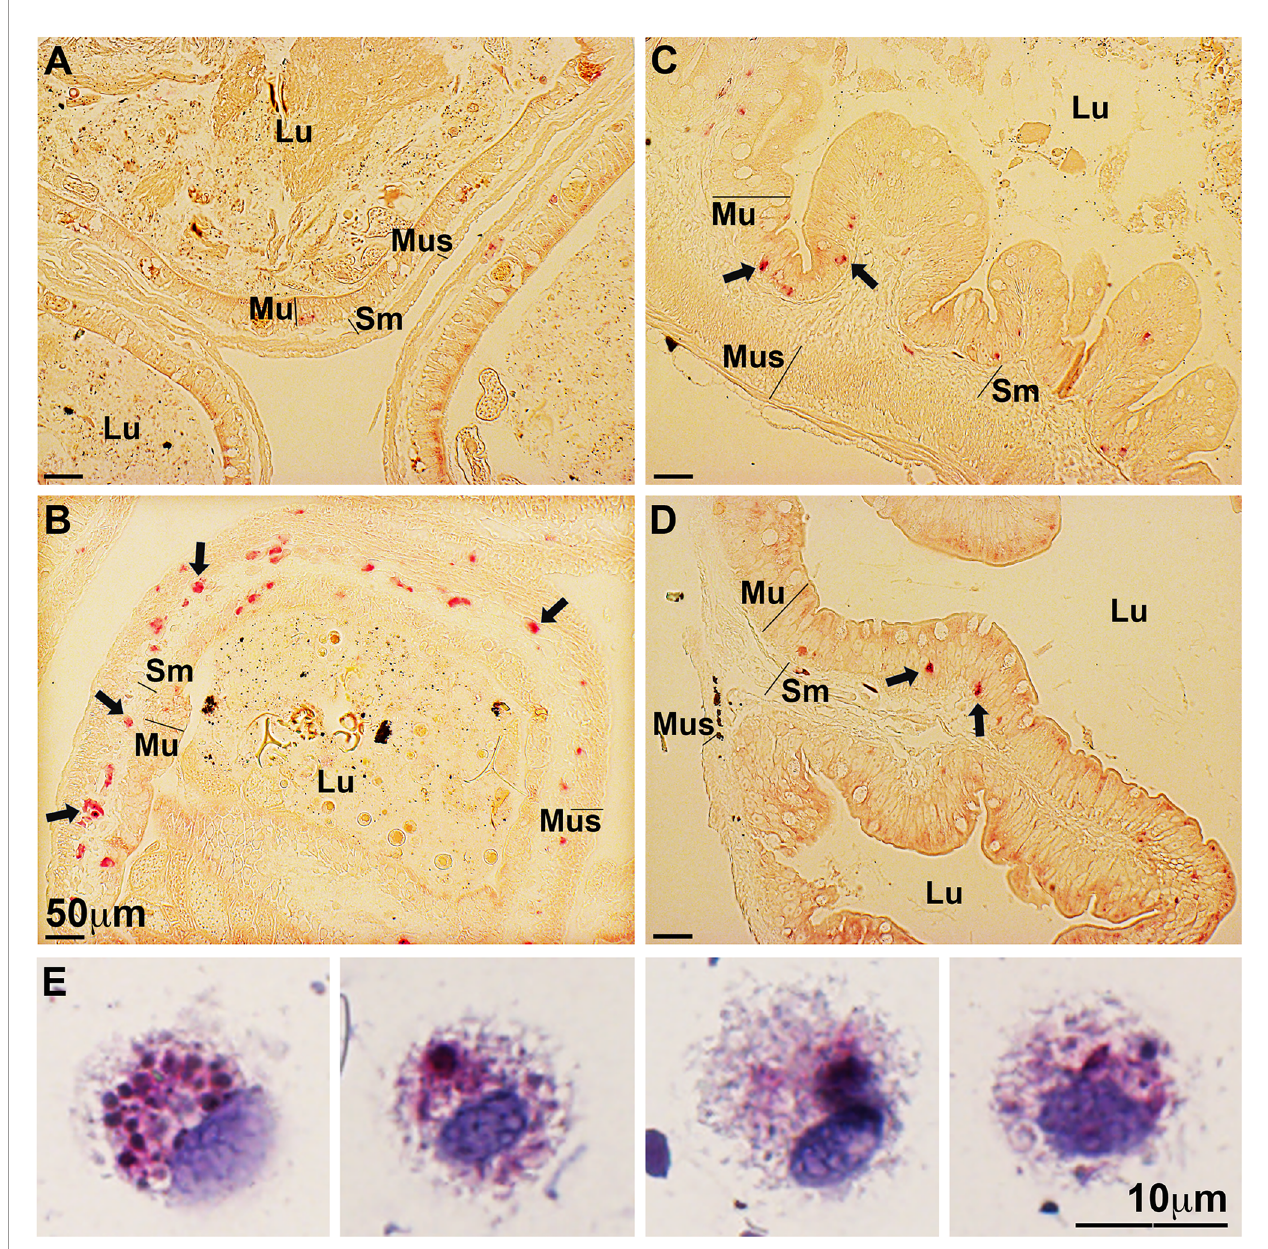
FIGURE 3 | FV3-infected tadpoles recruit esterase-positive myeloid cells into their intestines while adult frog intestines contain resident esterase-positive myeloid cells. Tadpoles and adult frogs were infected by water bath with 10 6 PFU of FV3 for 6 hrs. Their intestines were examined for the presence of speci fi c esterase- positive cells ( N =6 per treatment group) using the NASDCl- speci fi c esterase (Leder) stain. (A) Mock-infected and (B) FV3-infected tadpole intestines. (C) Mock- infected and (D) FV3-infected adult frog intestines. Lu, lumen; Mu, mucosal; Sm, sub-mucosal r; Mus, muscularis layers. (E) Morphology of esterase-positive cells from FV3-infected tadpole intestines. These results are representative of 3 separate